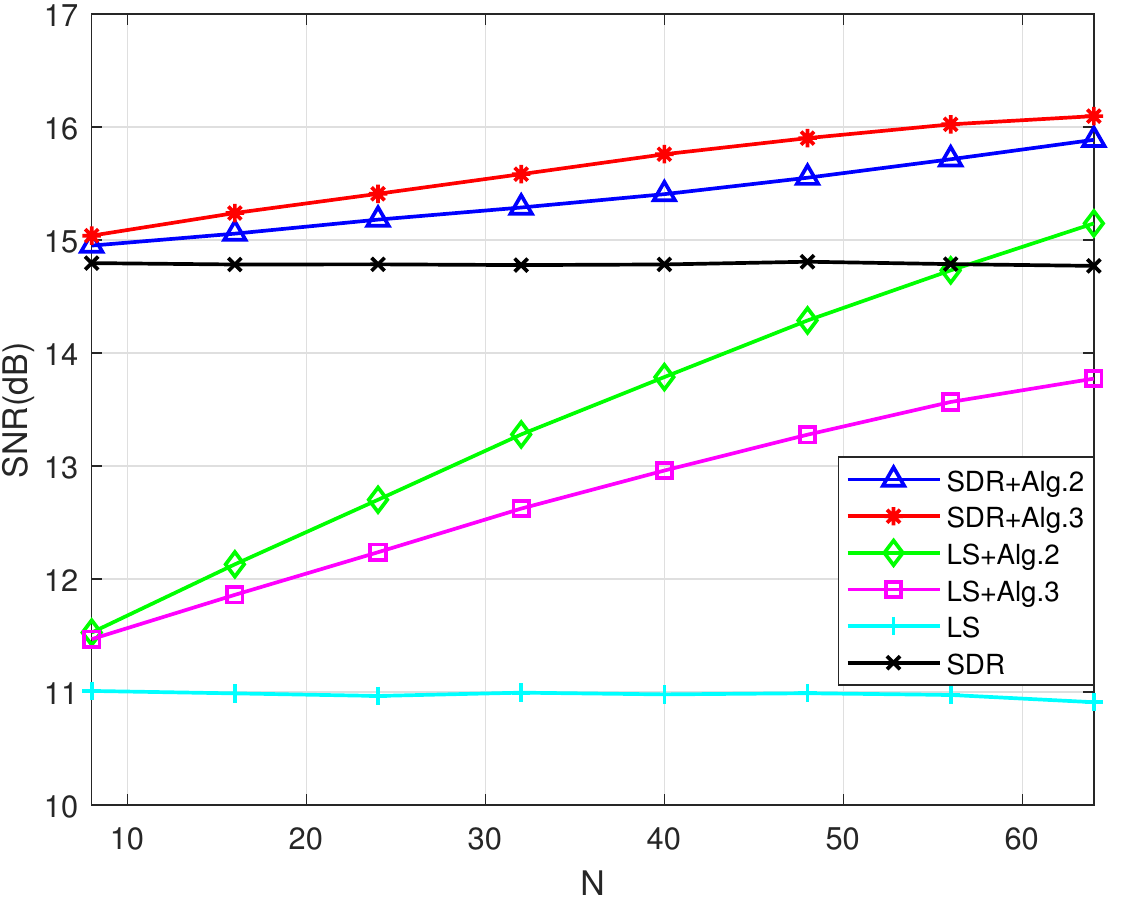
Figure 2. SINR performance comparison over the number of reflecting elements N in the under- loaded case. Here, P = 10, M = 8 and K =